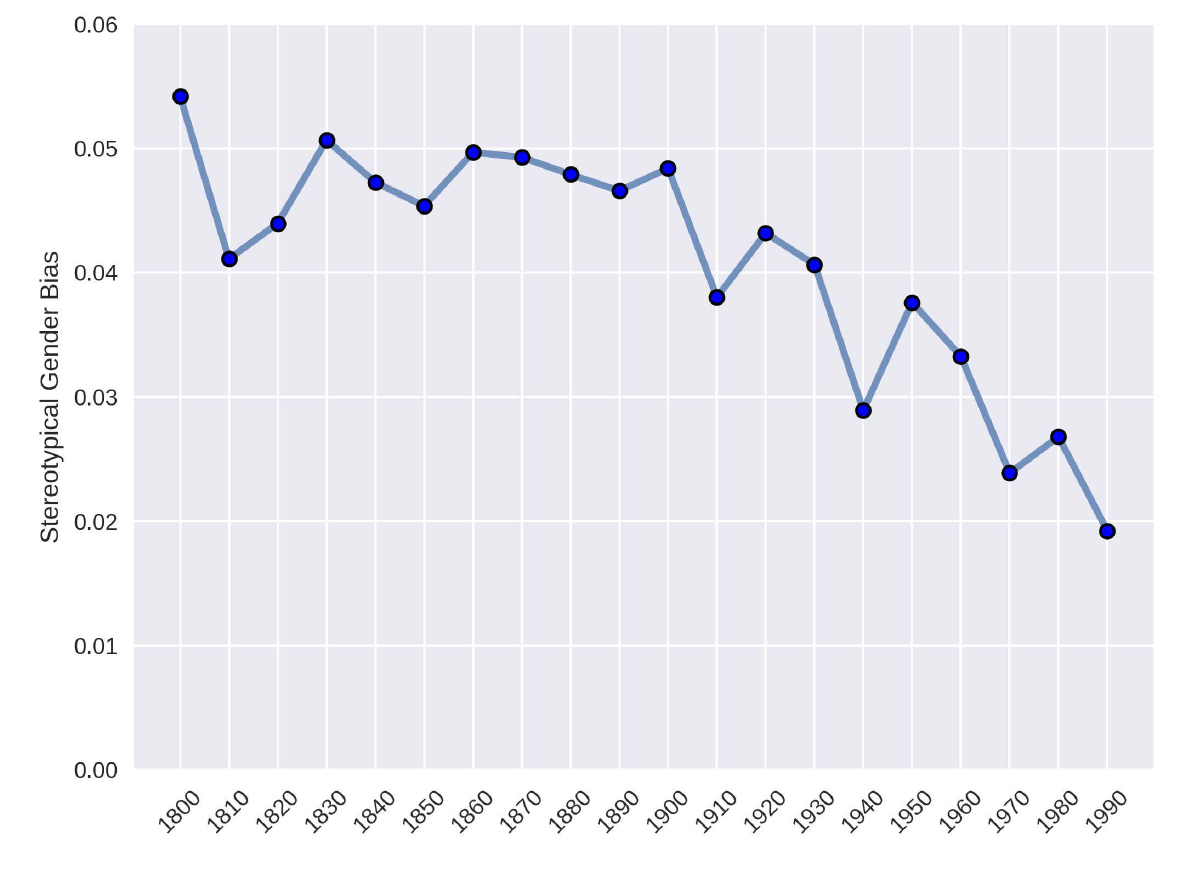
Figure 1: Composite stereotypical gender bias measured over time. Each data point represents the average of the absolute values of male gender bias for the four domains of Family, Career, Science, and Arts. The x axis is labeled with the first year of each decade (e.g., the label “1910” is used to mark the measurement based on the word embedding trained on text from 1910 up to but not including